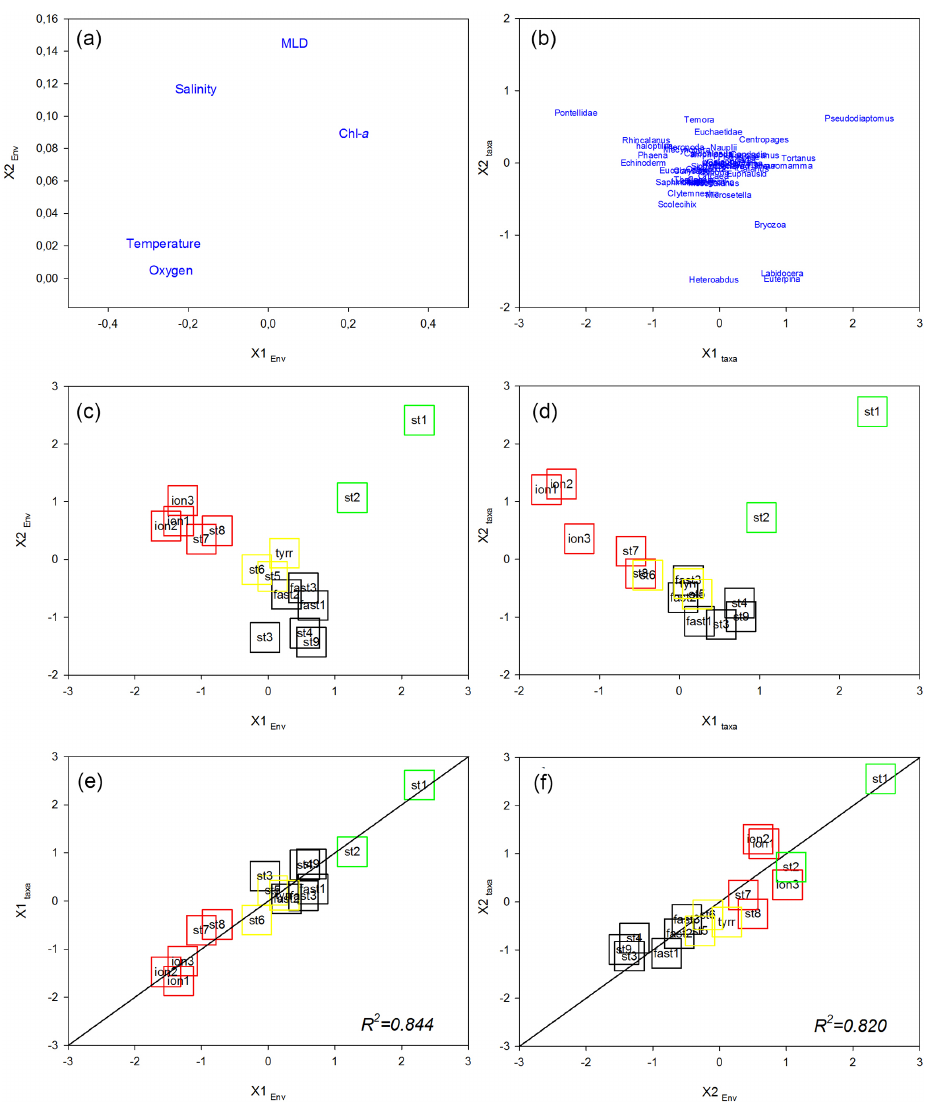
Figure 9. Co-inertia analysis. Ordination on the plans (1, 2) of the environmental variables (a) and the abundance of the zooplankton taxa (b) . Ordination on the plans (1, 2) of the stations in the “Environment system” (c) and in the “Zooplankton system” as well as plots of the stations on the first (c) and second (d) axes of the two systems. Lines represent the equality between the coordinates on the two systems. Colored squares identify the different regions: green denotes PB, black denotes AB, yellow denotes TB, and red denotes